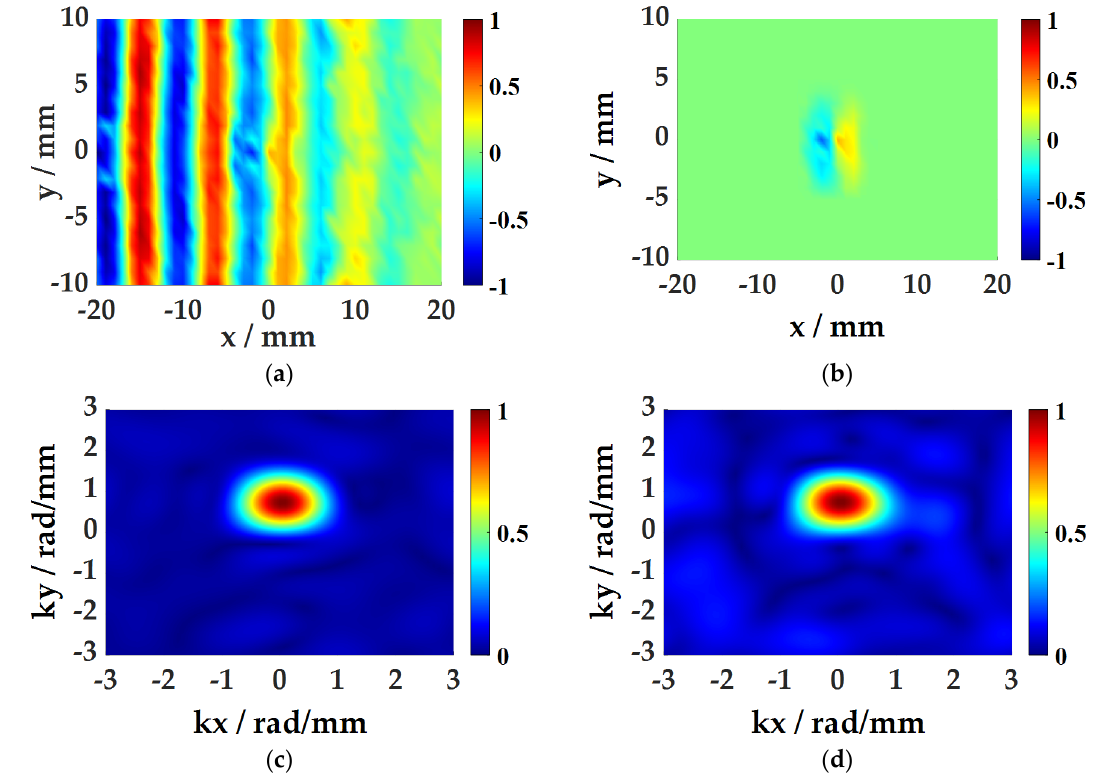
Figure 11. SWA process: ( a ) space-time domain data; ( b ) the windowed space-time domain data; ( c ) wavenumber domain spectrum at 200 kHz; ( d ) wavenumber domain spectrum at 220 kHz.